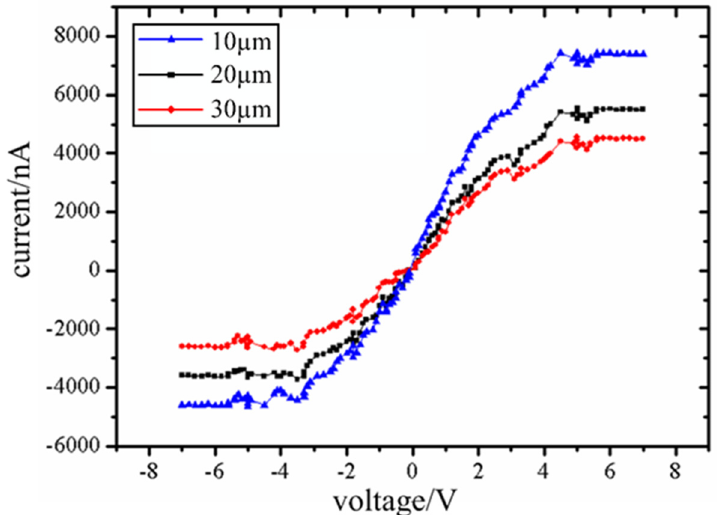
Figure 8. I-V curve of three groups of nanorods. Curve 1, curve 2 and curve 3 correspond to ZnO nanorods with length of 10 μ m, 20 μ m and 30 μ m respectively, with same diameters of 2 μ m. The three I-V curves are nearly symmetrical, which indicates that ZnO nanorods and probe form almost equal contact barriers between the forward bias junction and reverse bias junction.